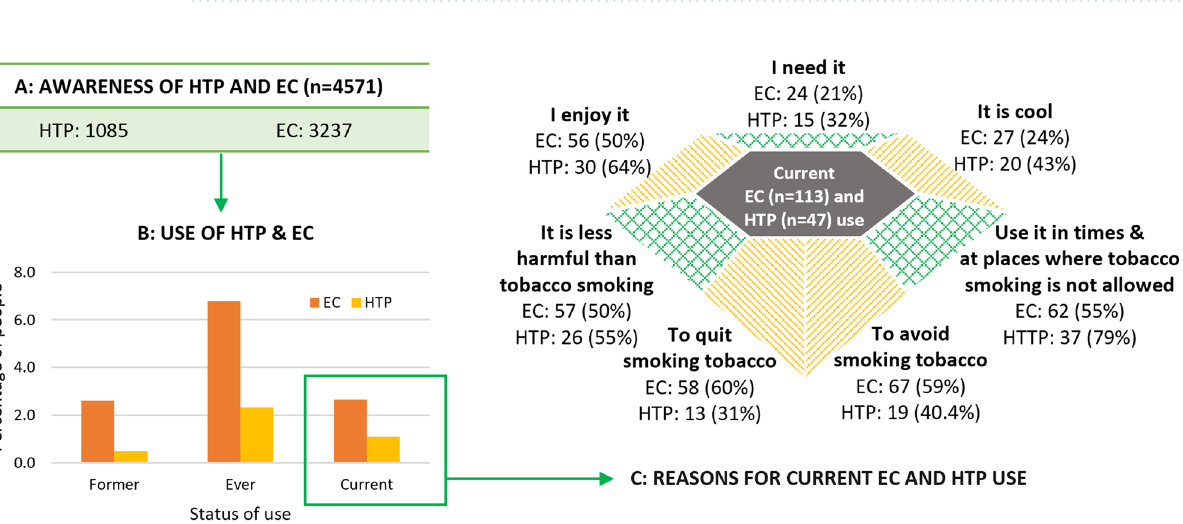
Table 3. Proportions (%) of EC and HTP awareness and use by adults according to their CS status (current, former, and never).